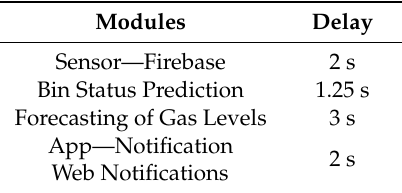
Table 5. Delay calculation of di ff erent